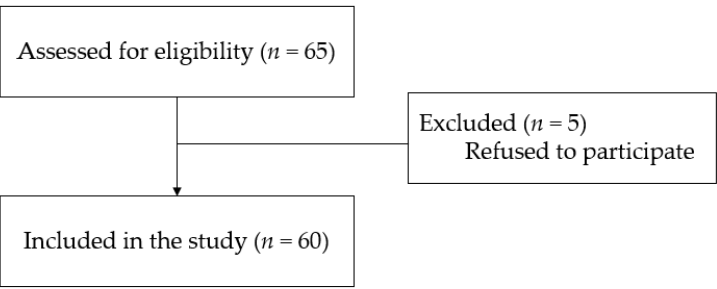
Figure 1. Study population.